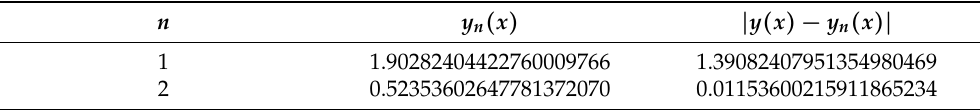
Figure 2. ( a ) Comparison between the solutions—( b ) error function for n = 10. Table 4. Applying the FPA for Example 1 with (cid:101) = 10 − 1 and x = 0.8.